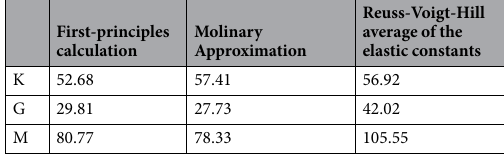
Table 2. Comparison of indentation modulus